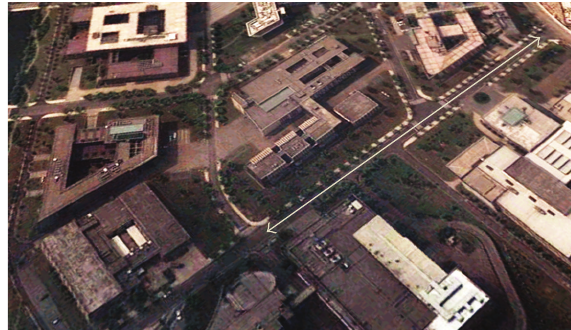
Figure 10: Field test Scenario 2.